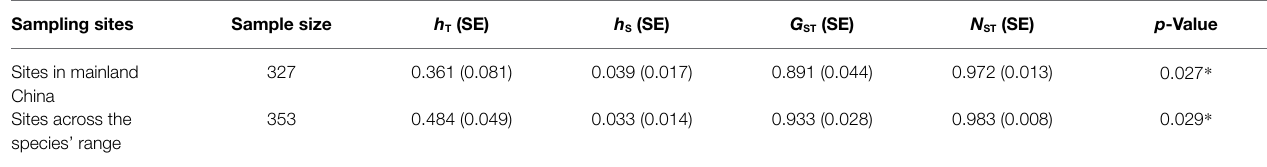
TABLE 2 | Genetic statistics of Toxicodendron vernicifluum based on the sequence variation at two chloroplast (cp) DNA markers. Sampling sites